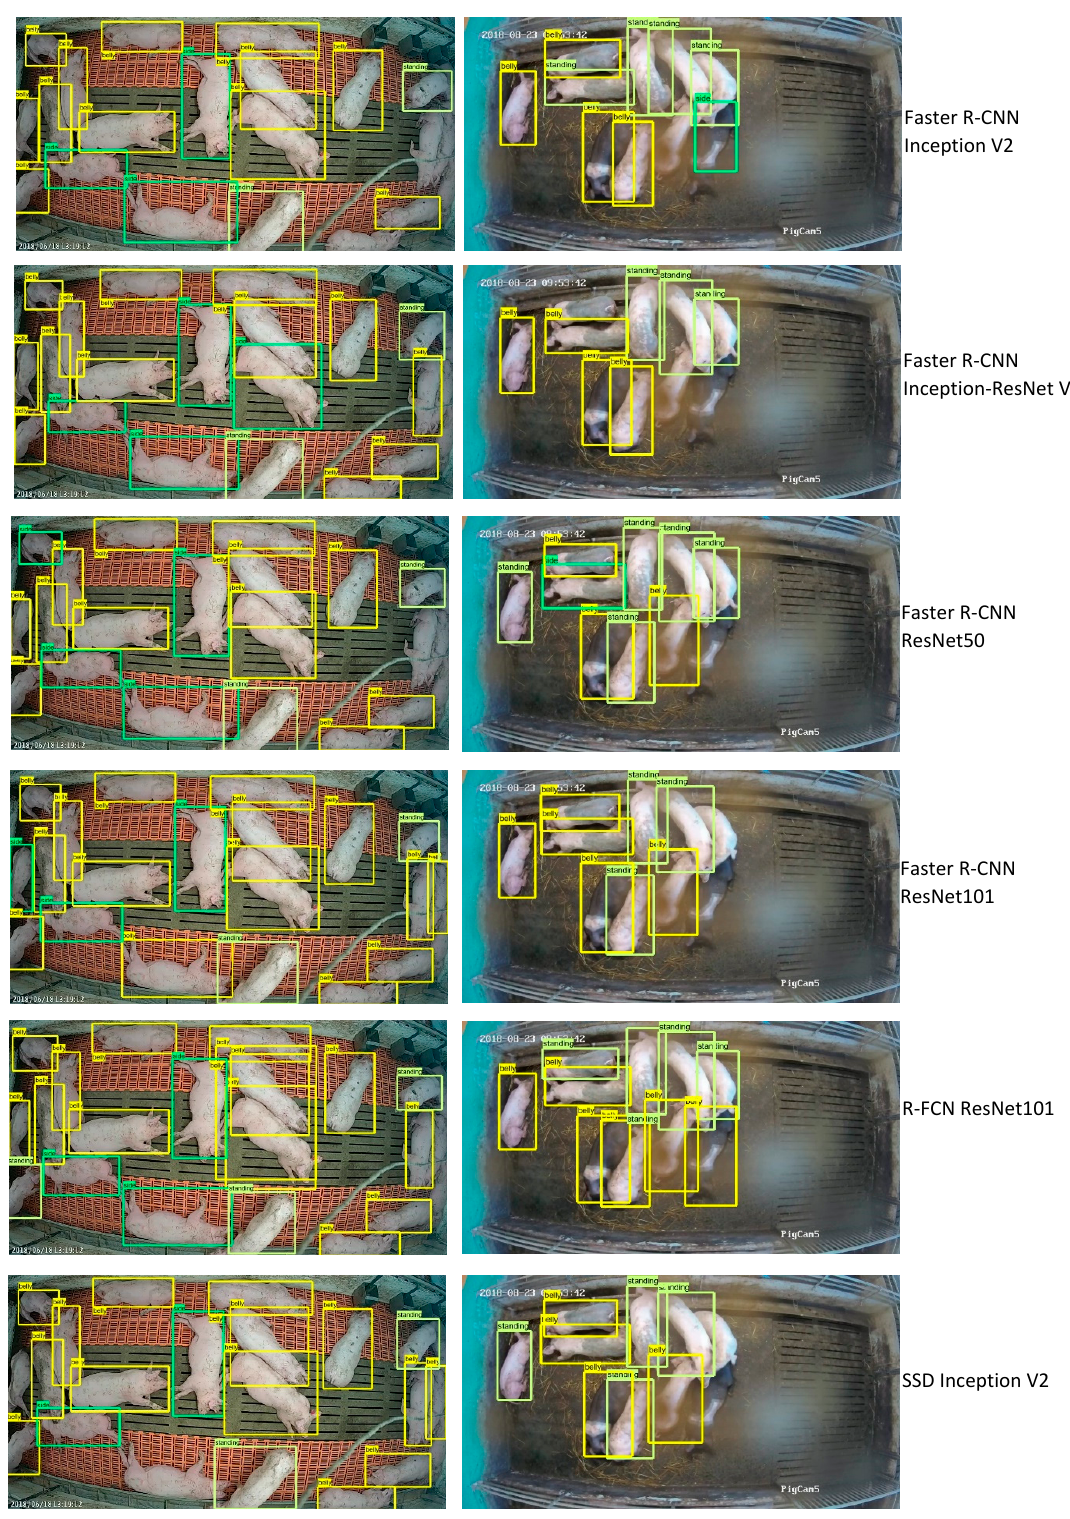
Figure 7. Examples of detected standing (light green rectangle), lying on belly (yellow rectangle) and side posture (green rectangle) of six different models in various farming conditions. Table 3. As can be seen in the table, the number of misdetections between standing and belly lying postures are higher than the other